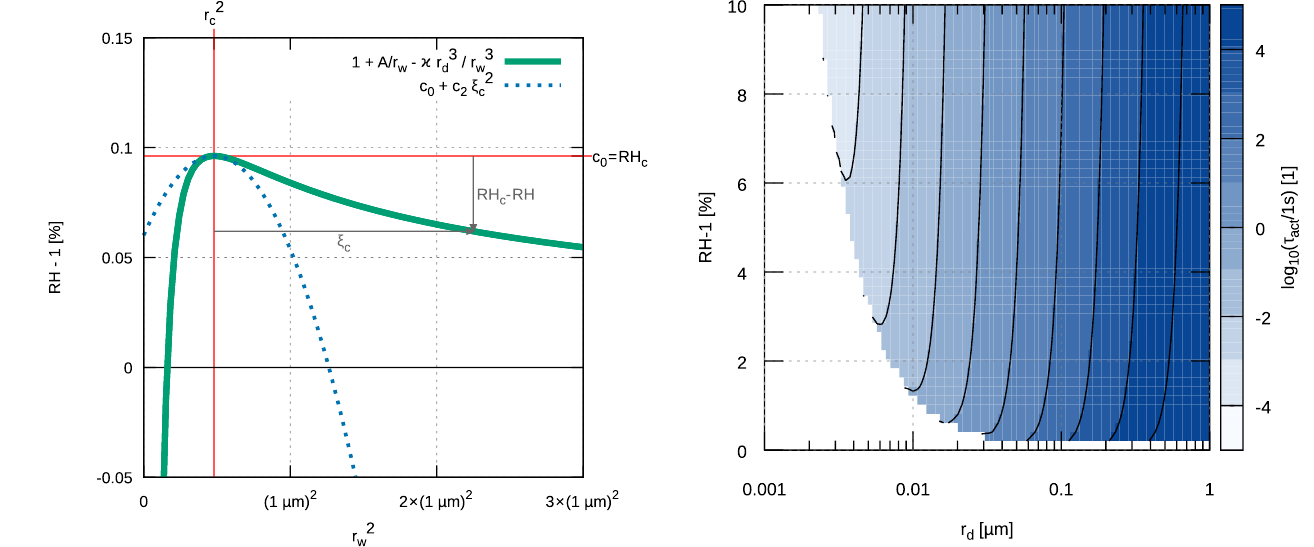
Figure 2. Köhler curve for CCN with r d = 0 . 05µm, κ = 1 . 28 (NaCl) and its Taylor expansions at r c and at infinity.